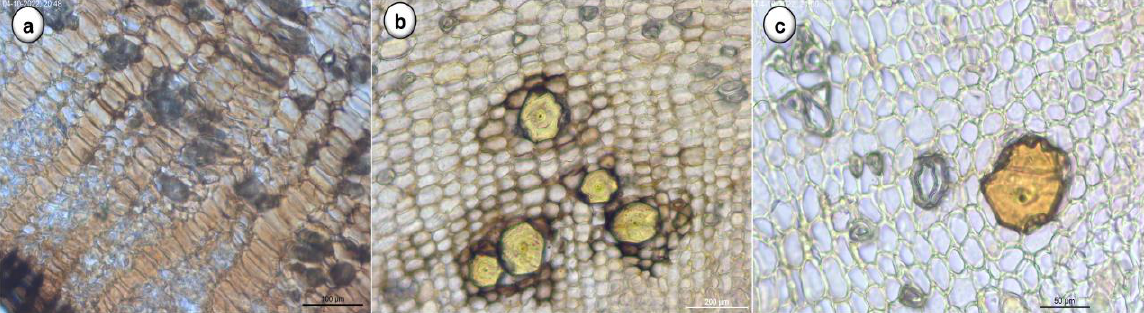
Figure 3. Transverse section of D. villosa root. ( a – c ): General aspects of cortical parenchyma ( a ): Groups of sclereids; ( b , c ): brachysclereids and sclereids; Bars: a = 100 µm; b = 200 µm; c = 100 µm.